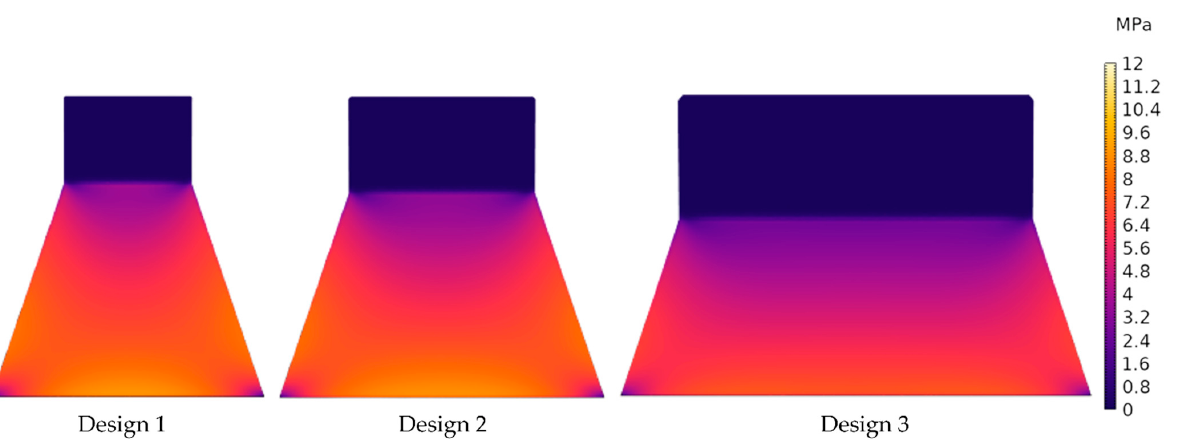
Figure 3. Schematic top view of the piezoelectric energy harvester designs with integrated NdFeB micromagnet arrays (corresponding cross-sections given in Figure 2). The angle α = 70° is kept constant in all designs.